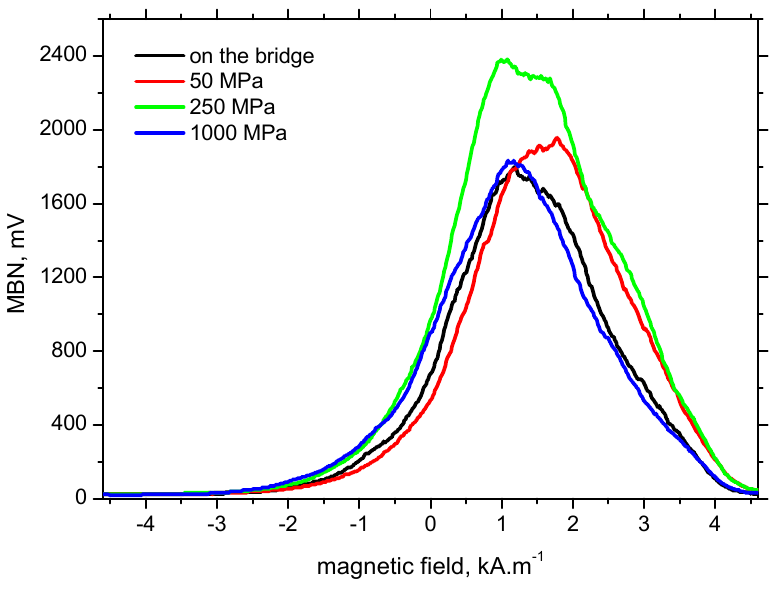
Figure 10. MBN envelopes for wire n.2.